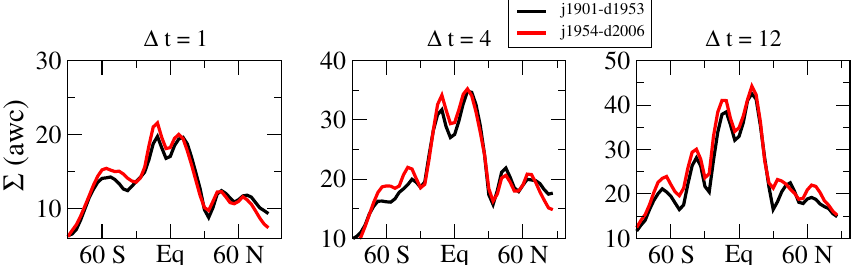
Figure 10. Zonal sum of the AWC function for the ICTP-AGCM networks built by using the BP methodology with 1t =1, 1t =4 and 1t =12, for both time periods (black: 1901–1953, red: 1954–2006). It is a measure of how many connections each latitude